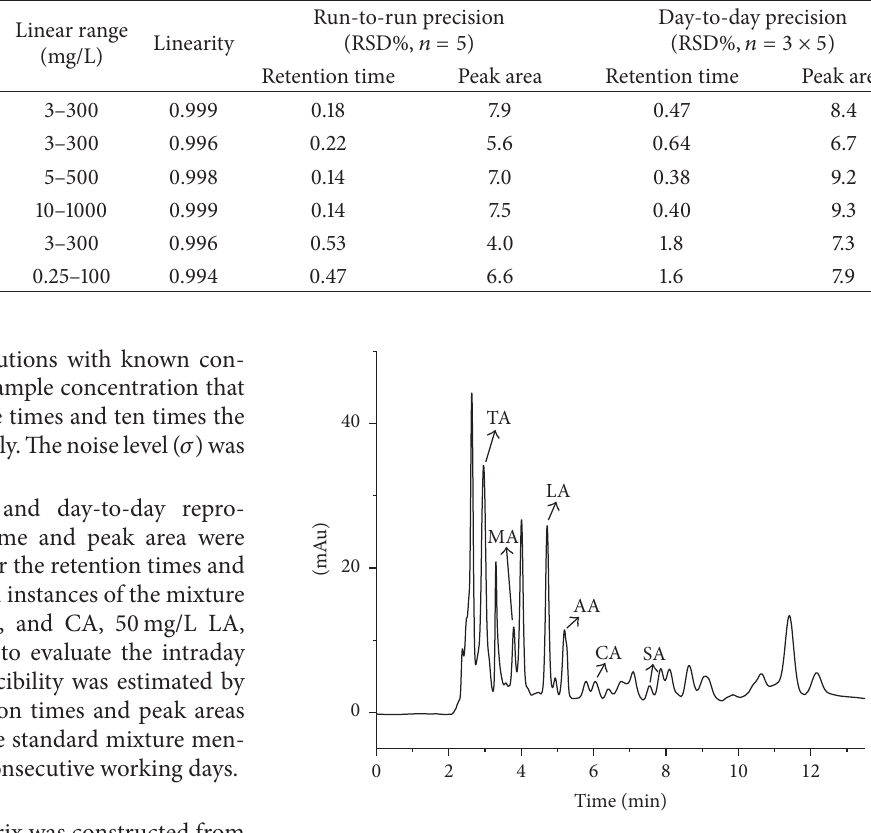
Table 2: Instrumental quality parameters for HPLC analysis of six organic acids.